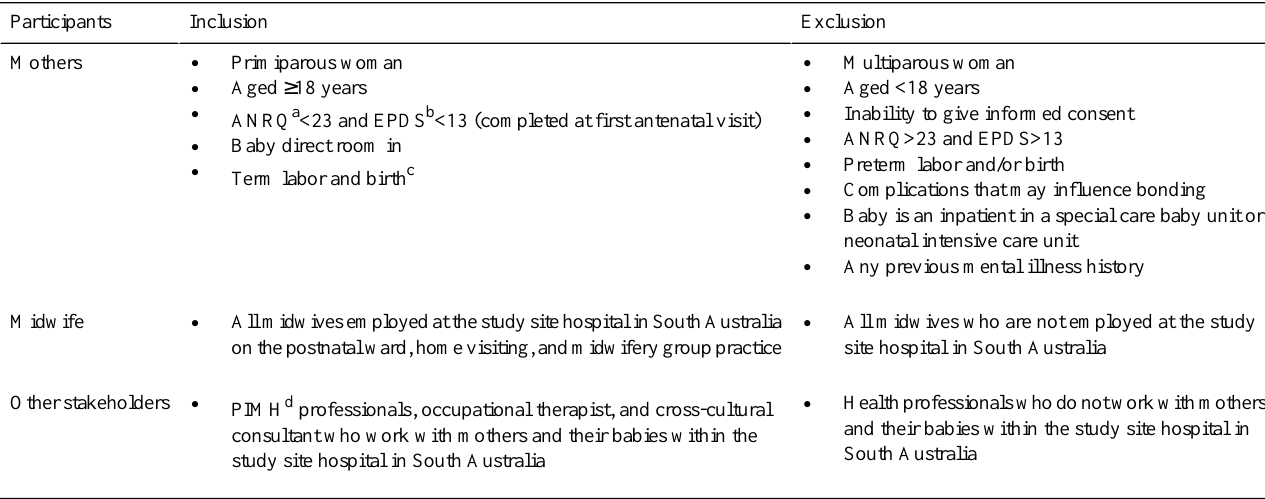
Table 1. Phase 1 and 2 inclusion and exclusion